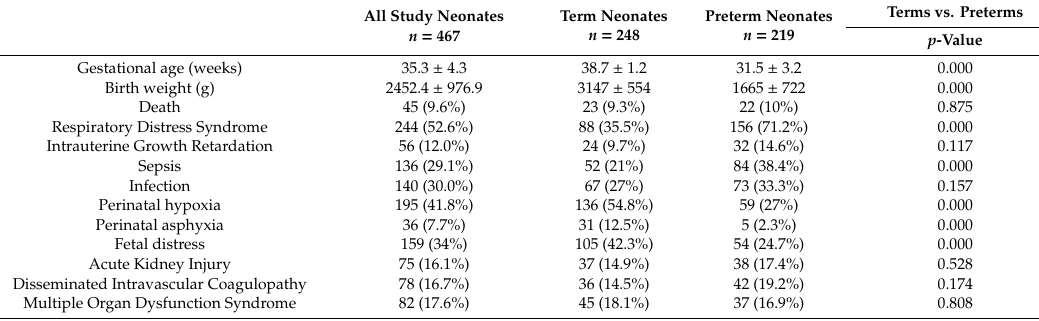
Table 2. Morbidities recorded in all neonates ( n =